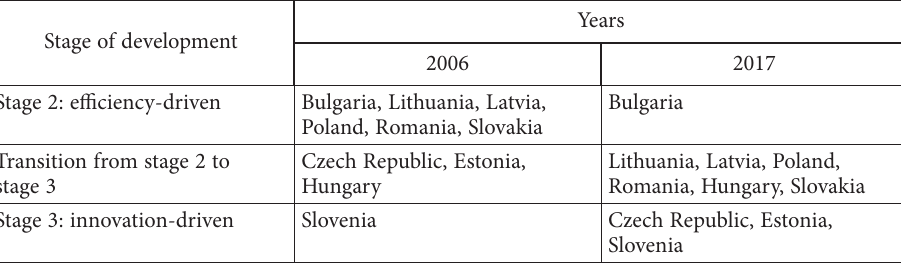
Table 3. Classification of the EU-10 by stage of development with GDP per capita thresholds (source: WEF, 2006, 2017) Stage of development